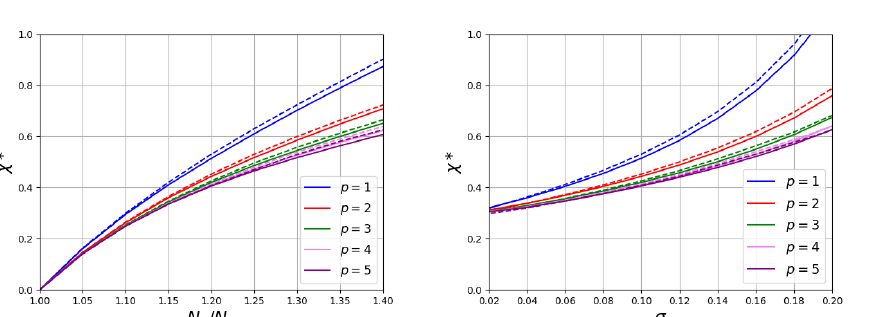
Figure 4. The values of transition points χ ∗ . ( The left picture ) shows the impact of the ratio of polymer- ization degrees of responsive and non-responsive chains at σ = 0.1. ( The right picture ) shows the impact of grafting density σ at N B / N A = 1.2. The polymerization degree of non-responsive polymer is varied: N A = 100 (solid lines) and N A = 200 (dashed lines). Kuhn lengths of both chains change simultaneously: p = p A = p B .